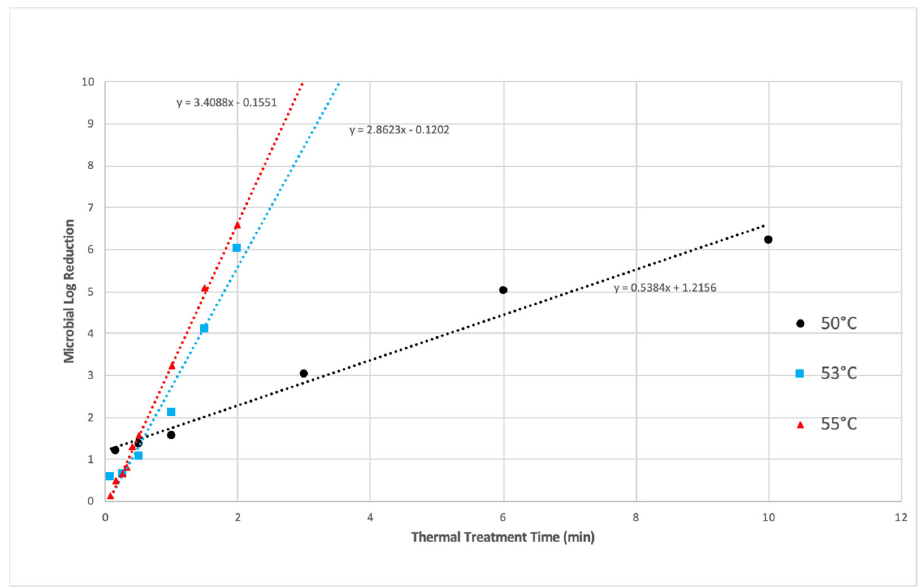
Figure 5. The effect of thermal treatment on E. coli suspended in a diluted protein shake drink beverage at different temperatures (data are means of two replicates).